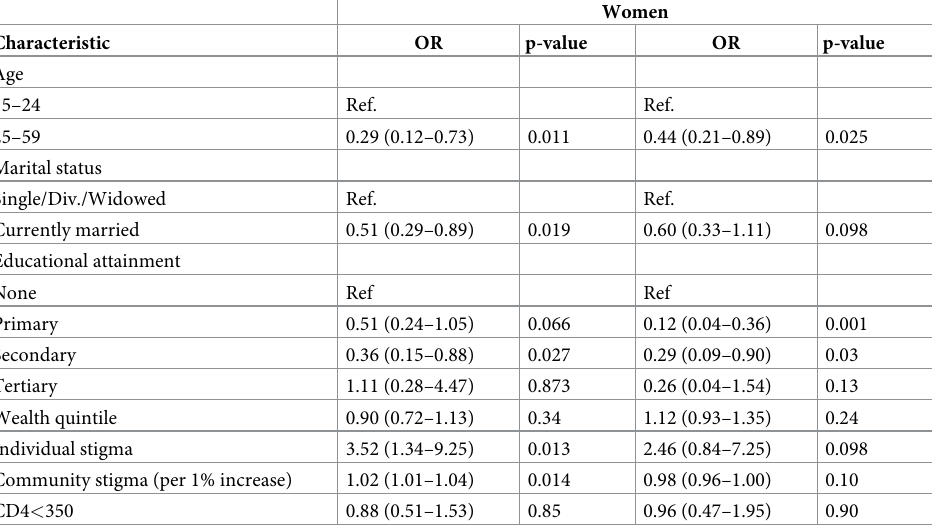
Table 4. Discordance between reported awareness of HIV status and detection of